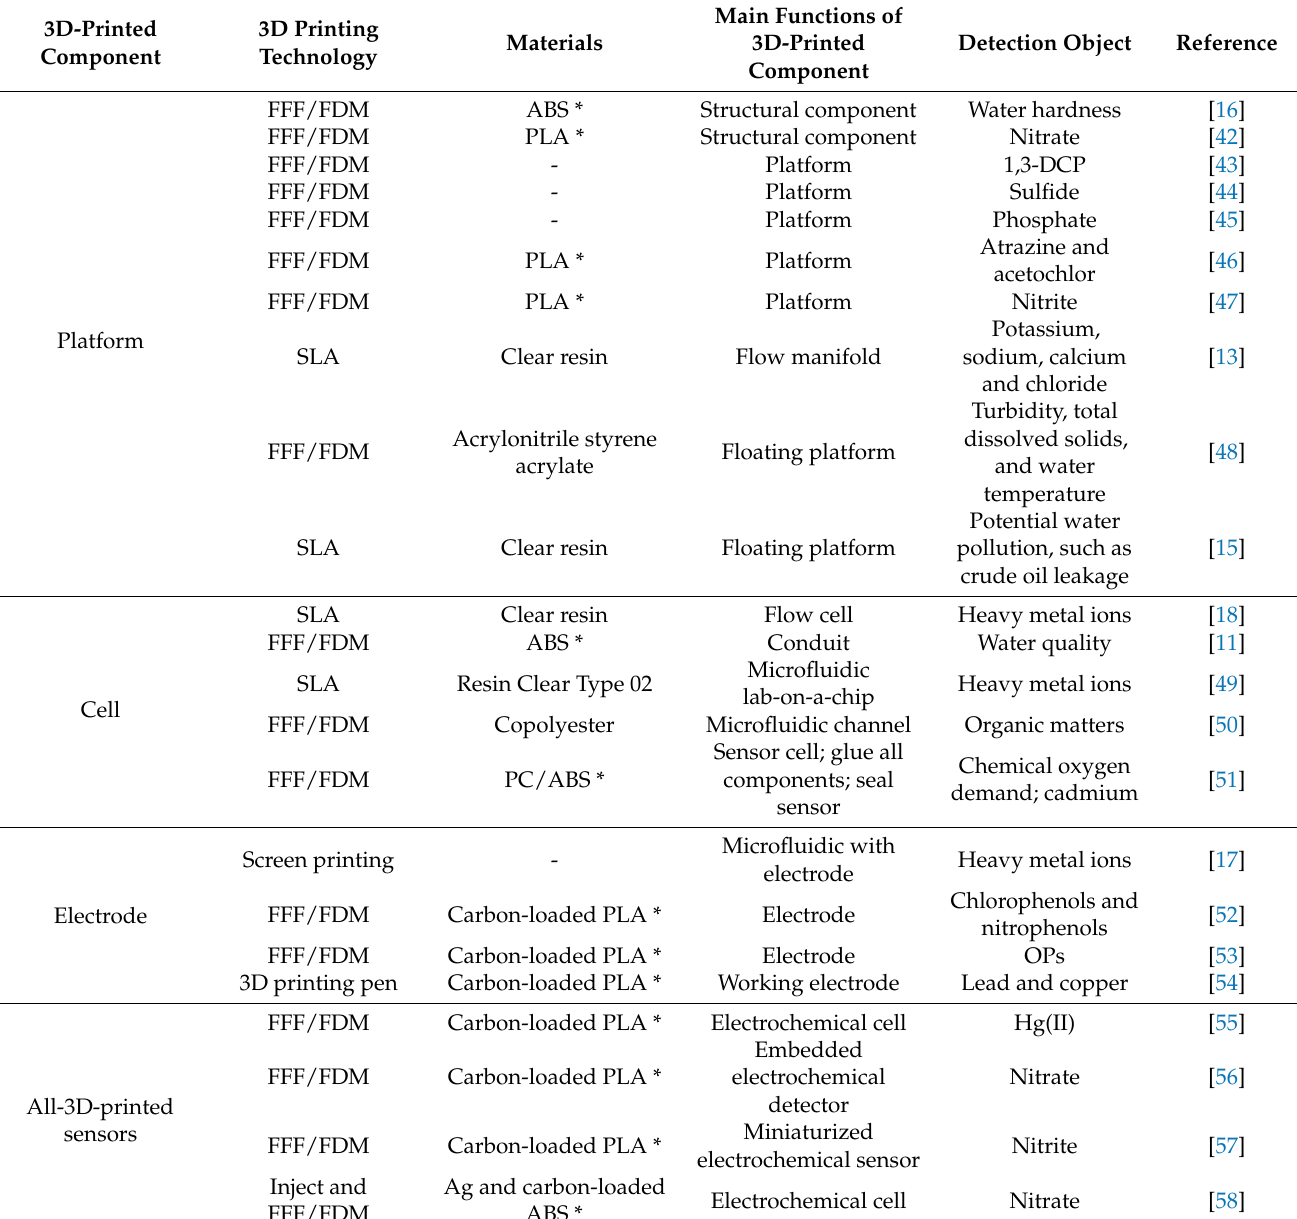
Table 1. Summary of 3D printing applications in sensors’